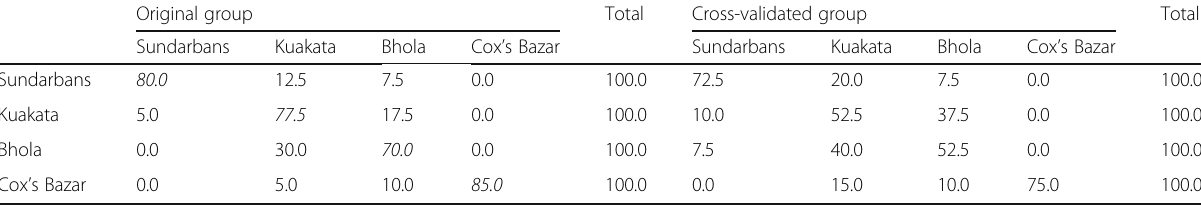
Table 9 Percentage of specimens classified into each group and after cross-validation for morphometric data Original group